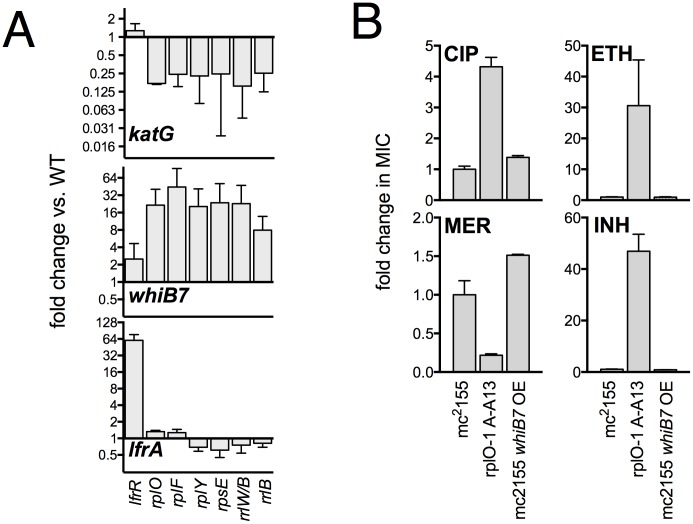
Confirmation of transcriptional changes by PCR and impact of WhiB7 overexpression on antibiotic susceptibility.(A) qRT-PCR confirmation of relevant transcriptional changes across a panel of mutant representing each affected ribosomal locus. Expression levels were normalized to sigA. Mean values of two experiments, each run in duplicate. Error bars = SE. (B) Constitutive expression of WhiB7 from the strong Psmyc promoter on a episomal plasmid does not reproduce the resistance profile of the rplO-1 mutant. Data are the average of 2 biological replicates ± SD.